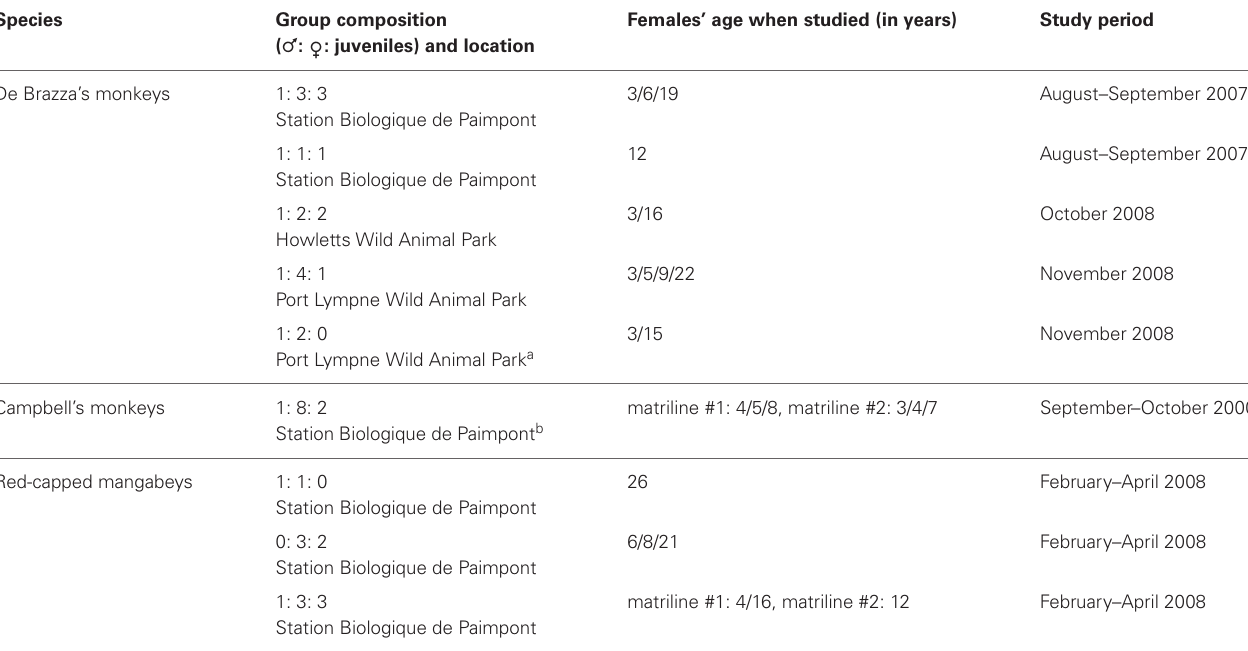
Table 1 | Subjects’ characteristics and study conditions. Species Group